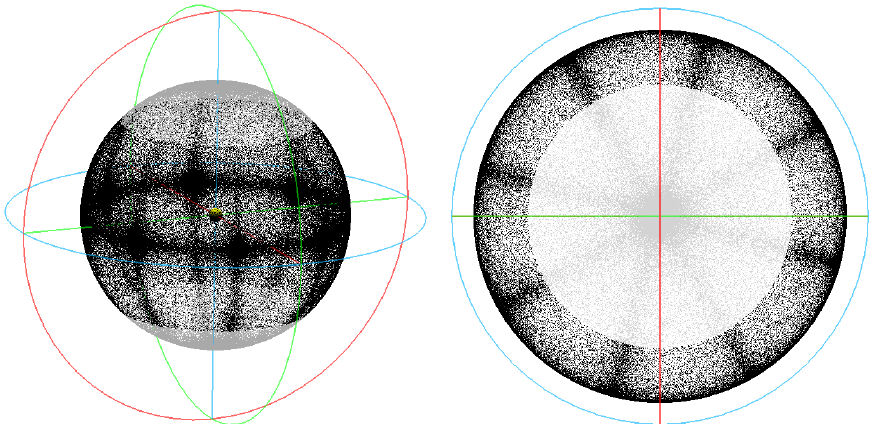
Figure 2 is rotated by 30° around the vertical axis relative to the ground truth pose aligned with the dominant Manhattan World structure.